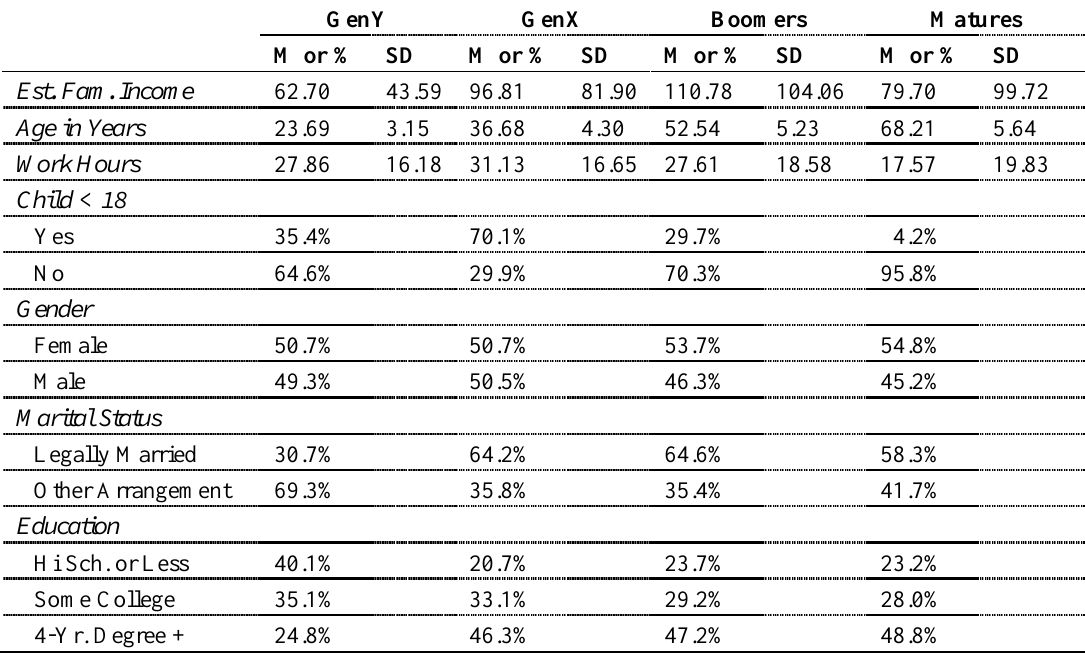
Table 2. Demographic variables by generational